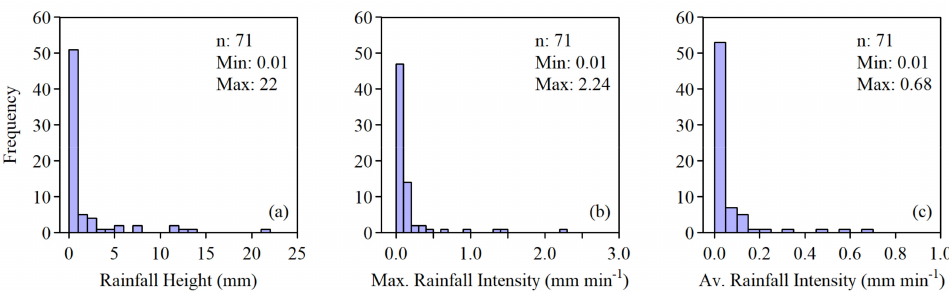
Figure 3. Descriptive analysis of rainfall height ( a ), maximum intensity ( b ) and hourly average of intensity ( c ) values, as acquired by the rain gauge of the W1M3A